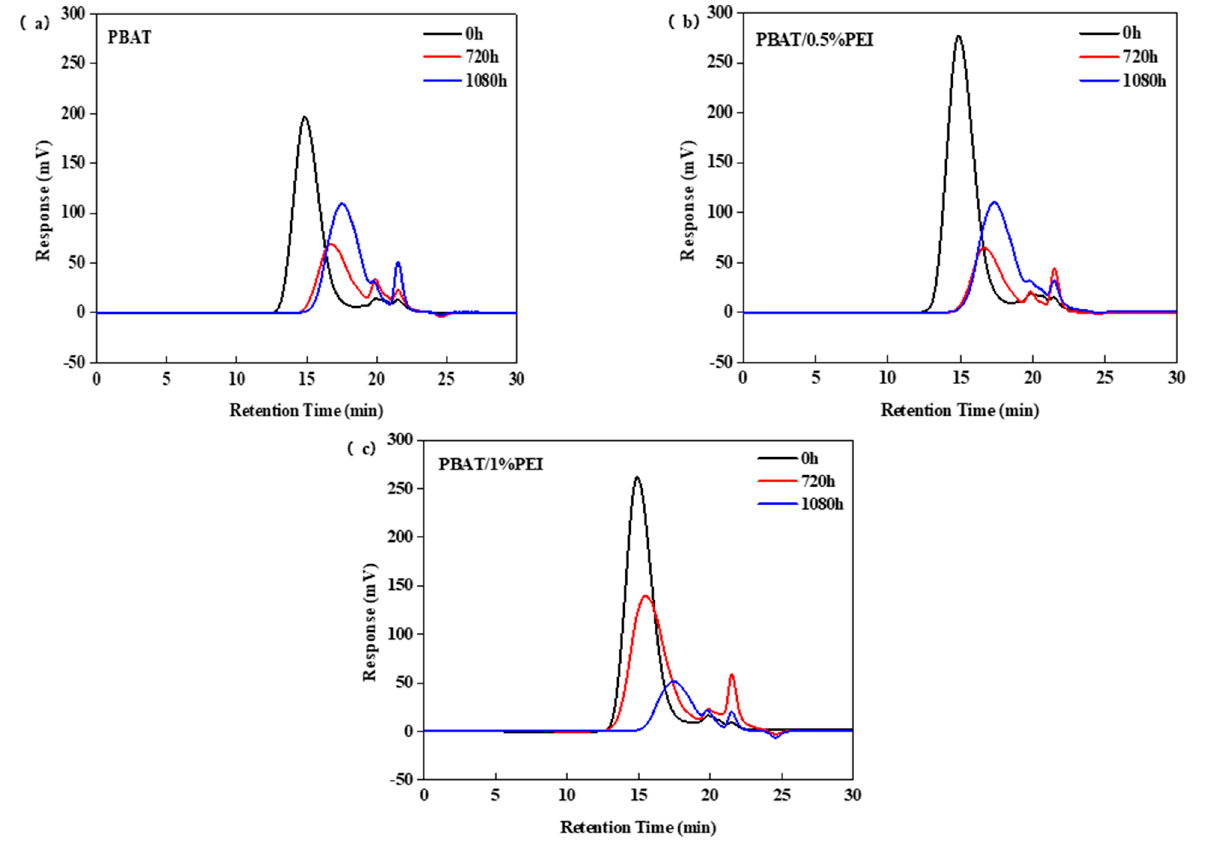
Figure 7. GPC curves for PBAT and PBAT/PEI films (photoaging for 0 h, 720 h, and 1080 h). ( a ) PBAT film; ( b ) PBAT/0.5%PEI film; ( c ) PBAT/1%PEI film.